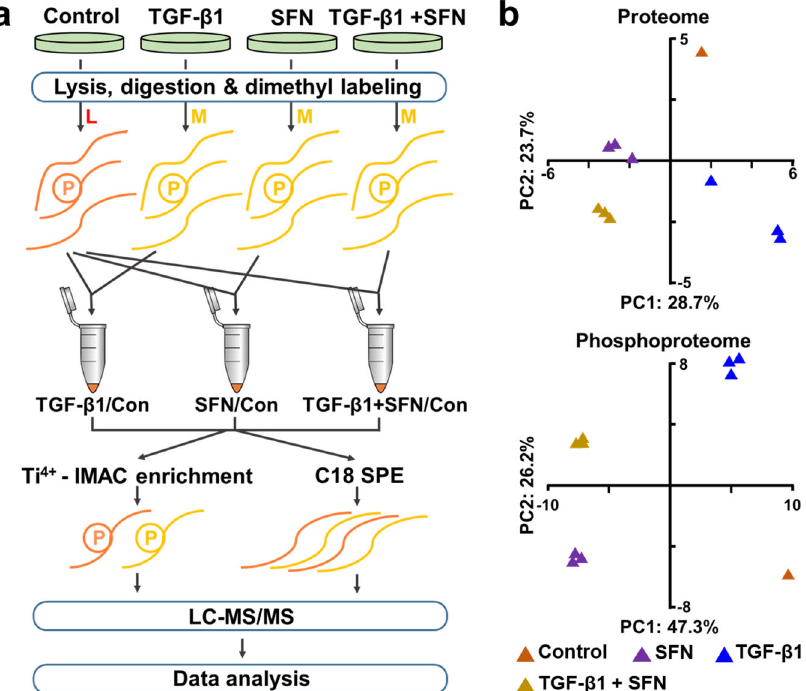
Fig. 4 Mass spectrometry-based quantitative proteomics and phosphoproteomic pro fi ling in MDA-MB-231 cells treated with TGF- β 1 in the absence or presence of SFN. a The work fl ow of the mass spectrometry-based phosphoproteomic analysis. b Principal-component analysis of all identi fi ed normal proteins and phosphorylation sites shows that samples cluster tightly according to biology. The log2 ratios of normal proteins and phosphorylation sites in the control group was defaulted to